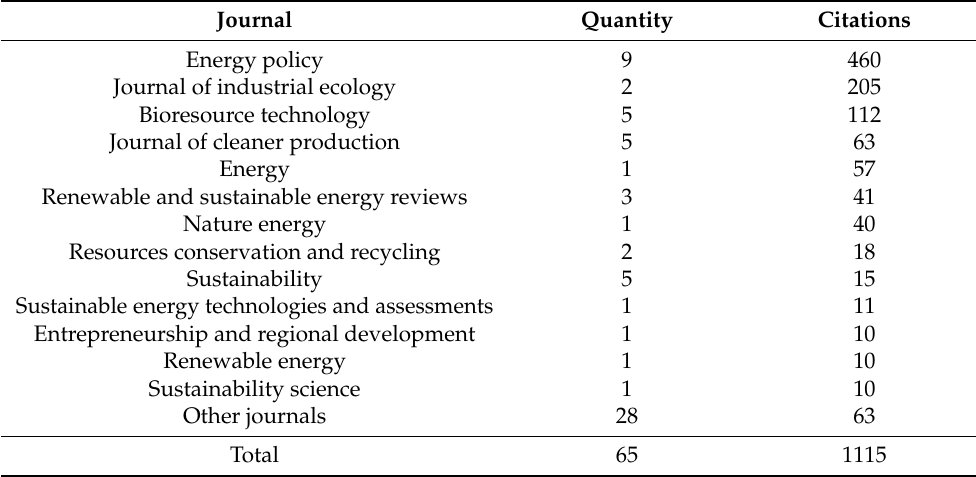
Table 2. Classification of journals with the greatest impact, with more than nine citations, and organized with more than two